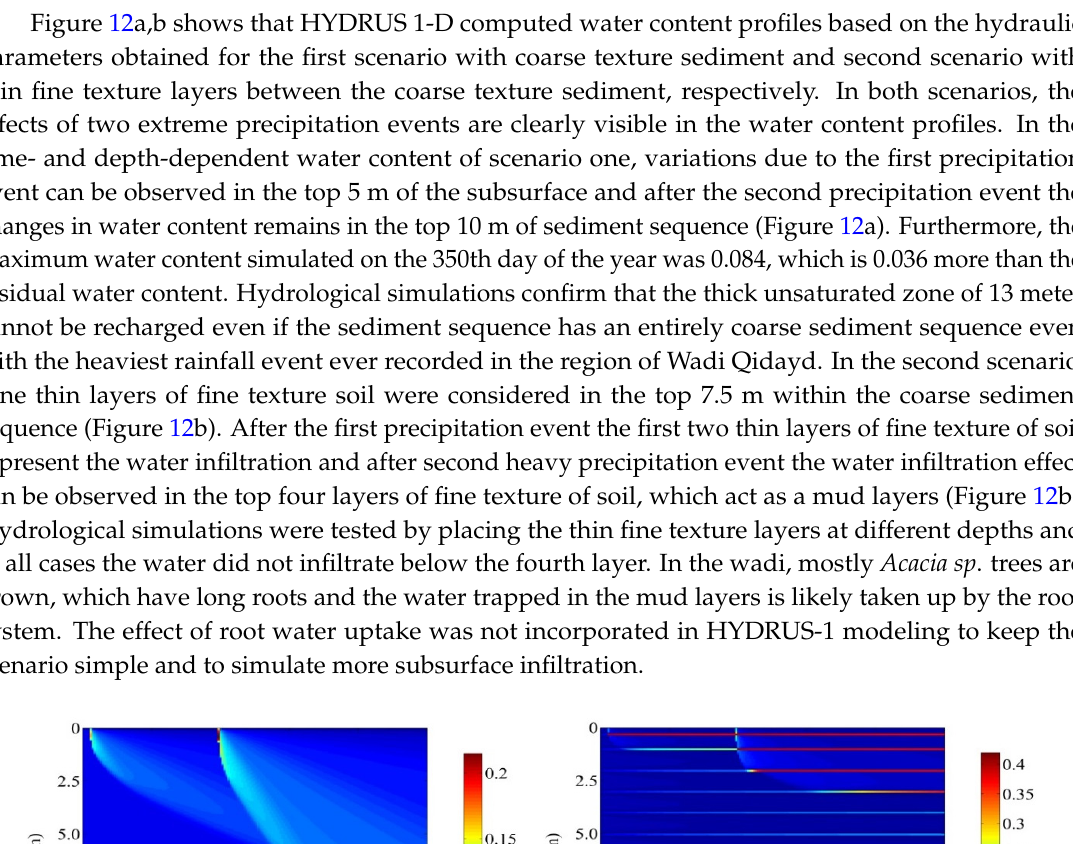
Figure 11. Precipitation and potential evaporation flux values recorded over a hundred-day period. Positive values are used for evaporation and negative for precipitation.